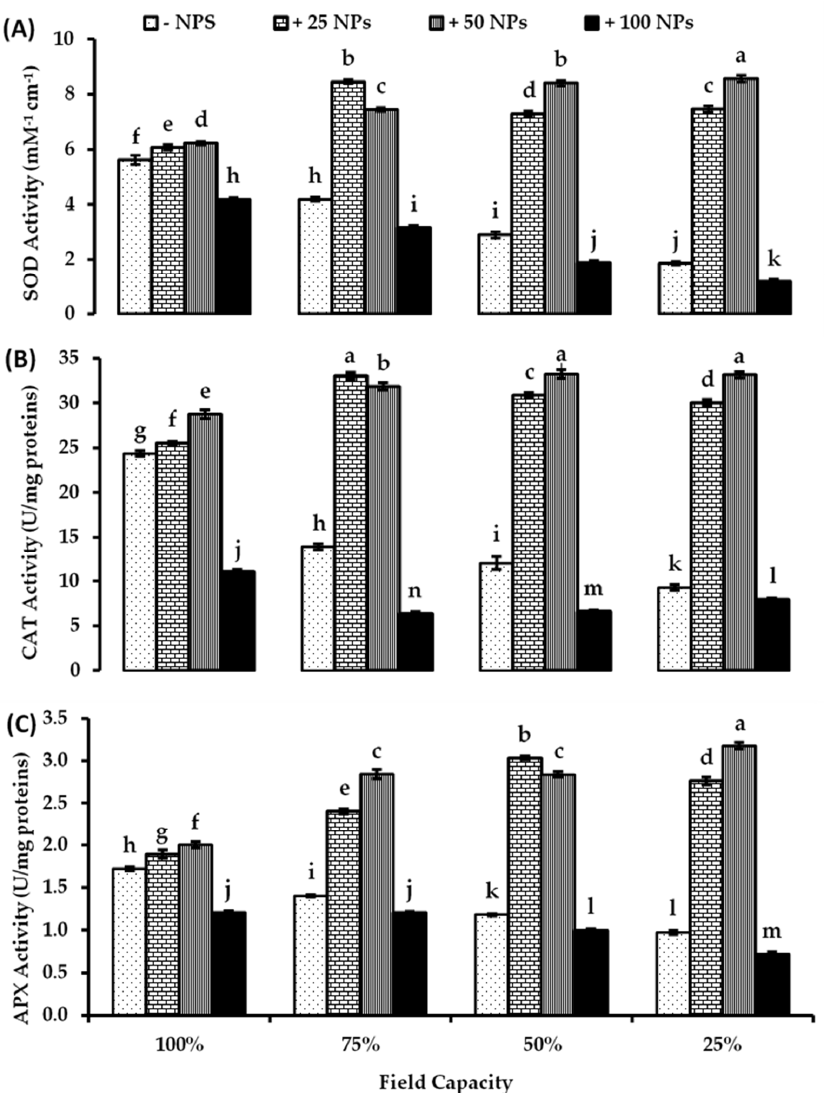
Figure 4. Antioxidant enzymes, ( A ) superoxide dismutase (SOD), ( B ) catalase (CAT), and ( C ) ascorbate peroxidase (APX) activity in tomato leaves as affected by foliar spraying with different concentrations of ZnO-NPs under different levels of drought stress. Each point represents a mean value of three replicates ( n = 3) with vertical bars representing the standard error of the mean. Bars with different letters indicate a significant difference ( p < 0.05) between Zn-O NPs treatments at all studied water levels as determined by two-way ANOVA and Bonferroni multiple comparison test.